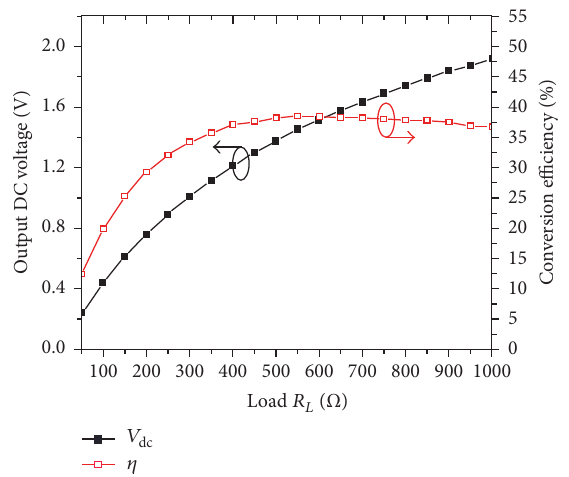
Figure 7: Measured output DC voltage and conversion efficiency versus frequency, 𝑃 in = 19 dBm, and 𝑅 𝐿 = 550 Ω